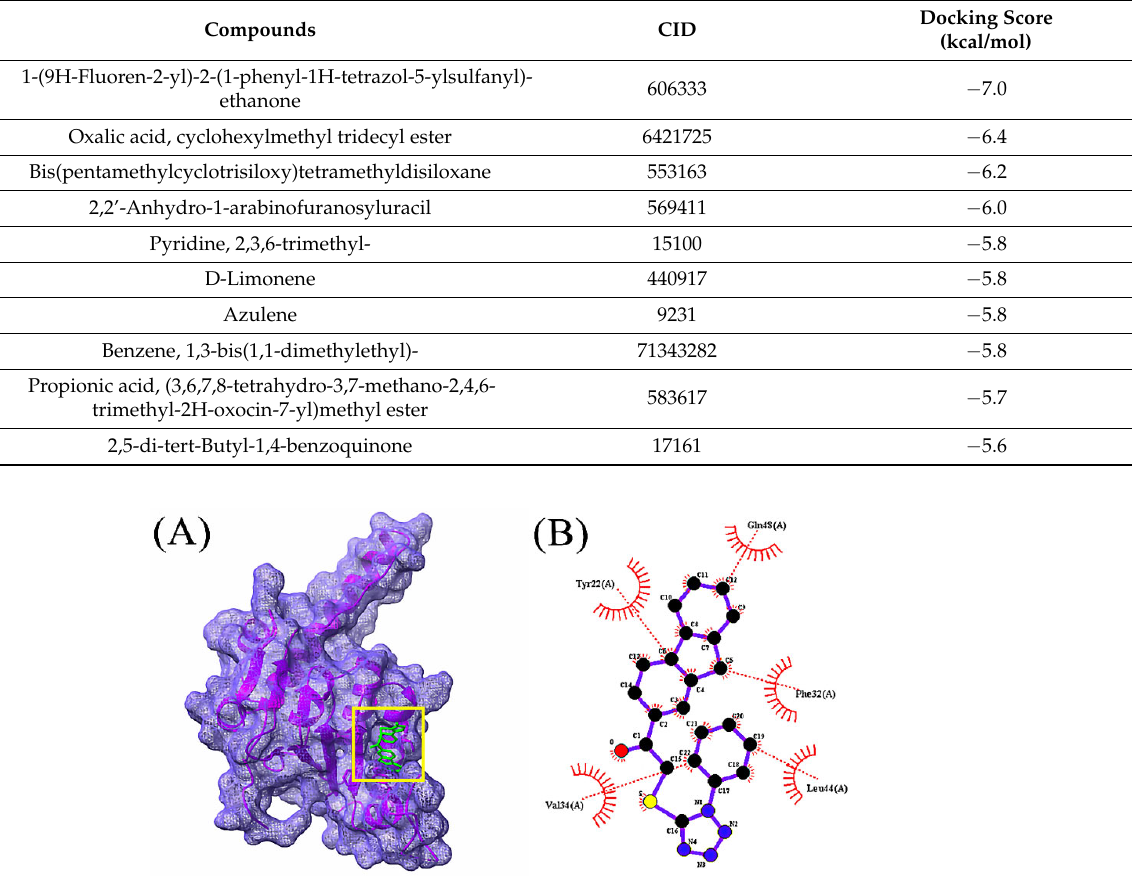
Figure 4. Docking simulation between protein ‐ ligand interactions of caseinolytic protease (Clp) enzymes Bacillus subtilis (PDB ID: 7M1M) and 1 ‐ (9H ‐ Fluoren ‐ 2 ‐ yl) ‐ 2 ‐ (1 ‐ phenyl ‐ 1H ‐ tetrazol ‐ 5 ‐ ylsulfanyl) ‐ ethanone, where ( A ) Surface view using Chimera (binding pocket), ( B ) 2D view using LigPlot+.